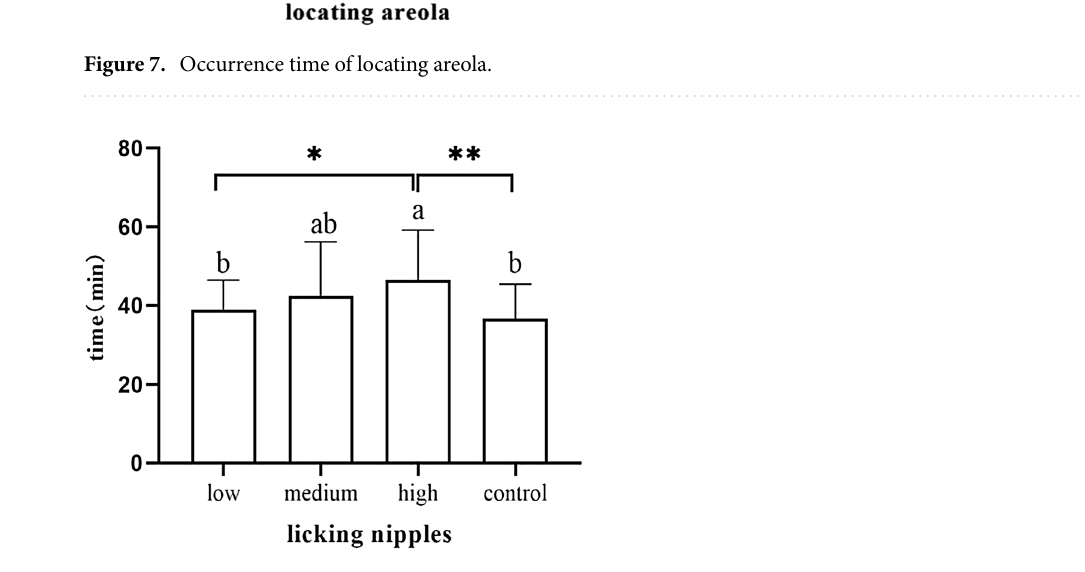
Figure 8. Occurrence time of licking